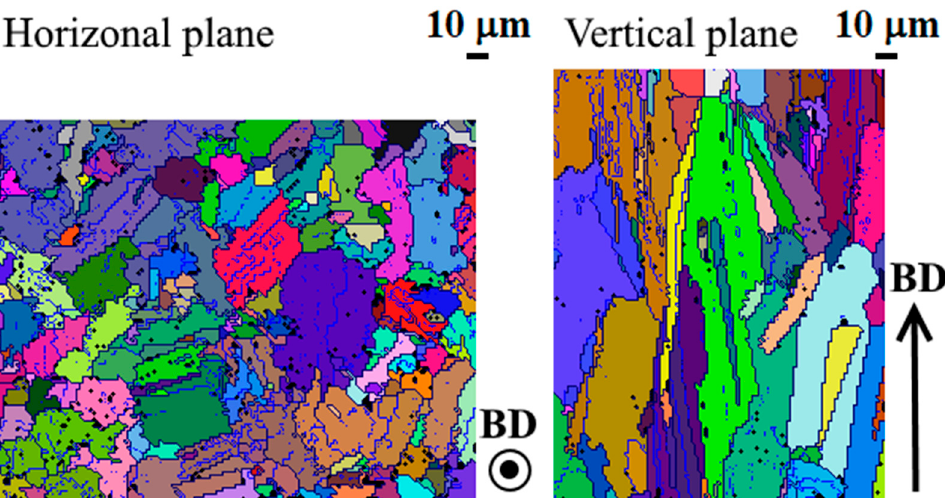
Figure 5. Grain maps of the horizontal and vertical planes of the selective laser melting (SLM) Inconel 718. The boundaries with a maximum misorientation angle of 10° or above are shown in dark blue, while the boundaries with a maximum misorientation angle between 4° and 10° are shown in lighter blue. The colors are used to distinguish the grains, with different shades of the same color indicating sub-granular crystalline domains within a single grain.